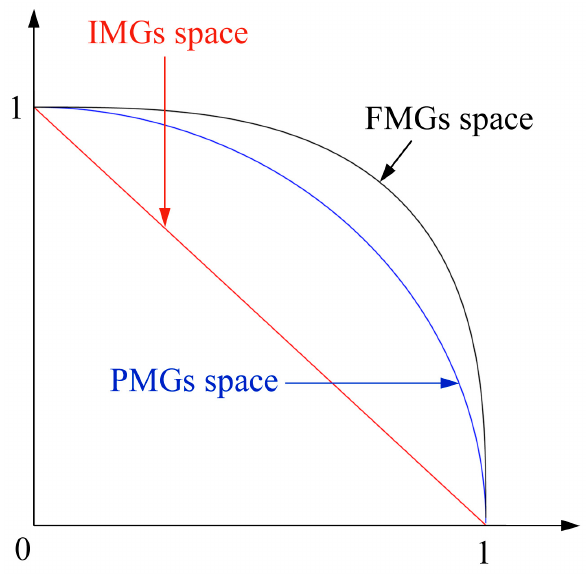
Figure 4. Spaces related to IMGs, PMGs, and FMGs.